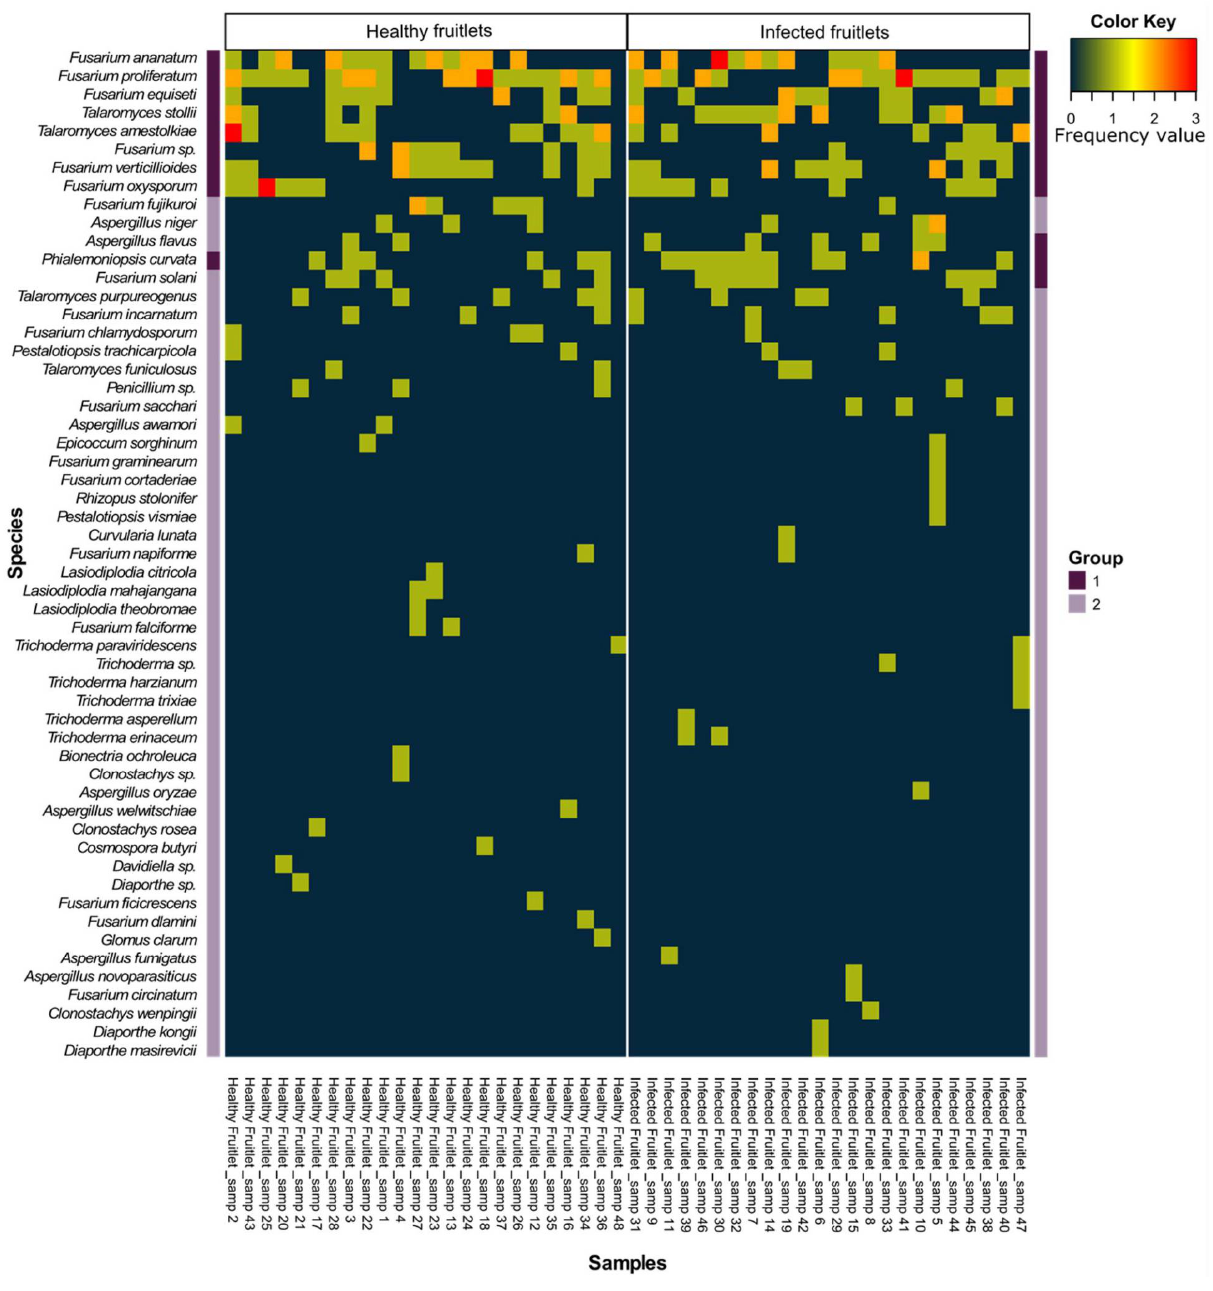
Figure 5. Heat map representation of fungal species frequencies in healthy and infected fruitlets of each quadrat. Group 1 corresponds to species identified in at least 25% of healthy and infected fruitlet sets, and Group 2 shows species identified in less than 25% of healthy and infected fruitlet sets.